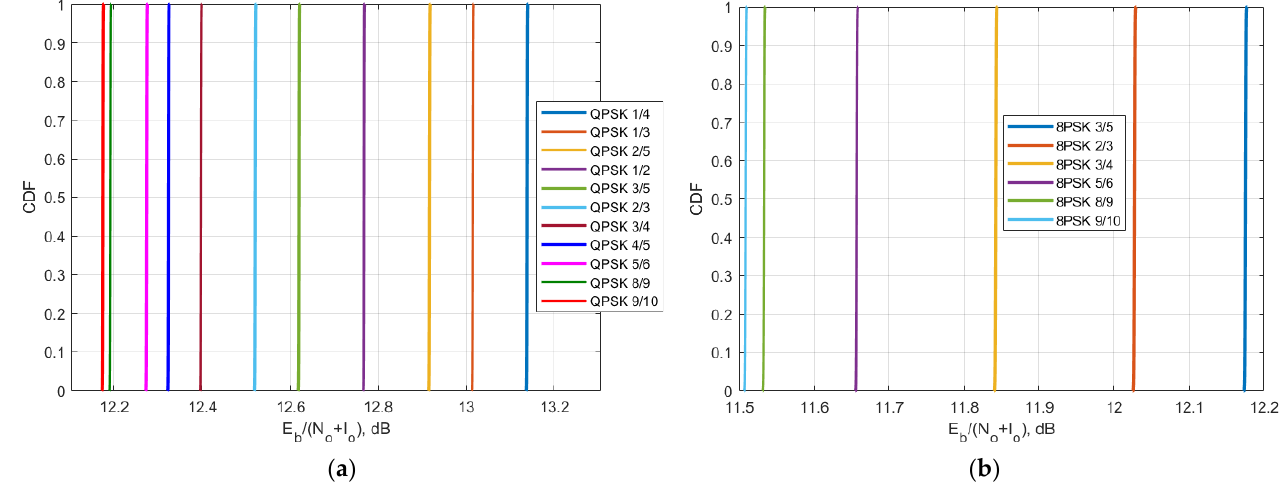
Figure 15. The CDF of E b /N o +I o of Yamal 183E: ( a ) for QPSK modulation; ( b ) 8PSK modulation.